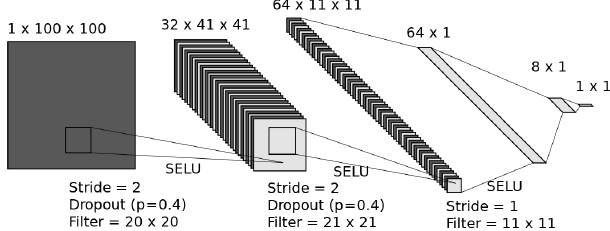
Figure 5. ConvNet architecture, using three convolutional layers and two fully connected layers, for predicting the mean thickness (1 × 1 output) of a 20m × 20m (100 × 100 input) lidar scan win- dow at 0.2m resolution (LeNail, 2019). The 64 × 1 layer is made by reshaping the 64 × 1 × 1 output of the final convolutional layer, and so is visually combined into one layer. The optimizer used was Adam with weight decay 1 . 0 × 10 − 5 (Kingma and Ba, 2014). The initial learning rate was η = 3 × 10 − 3 and reduced by a factor of 0.3 every 100 epochs until it reached 9 × 10 − 5